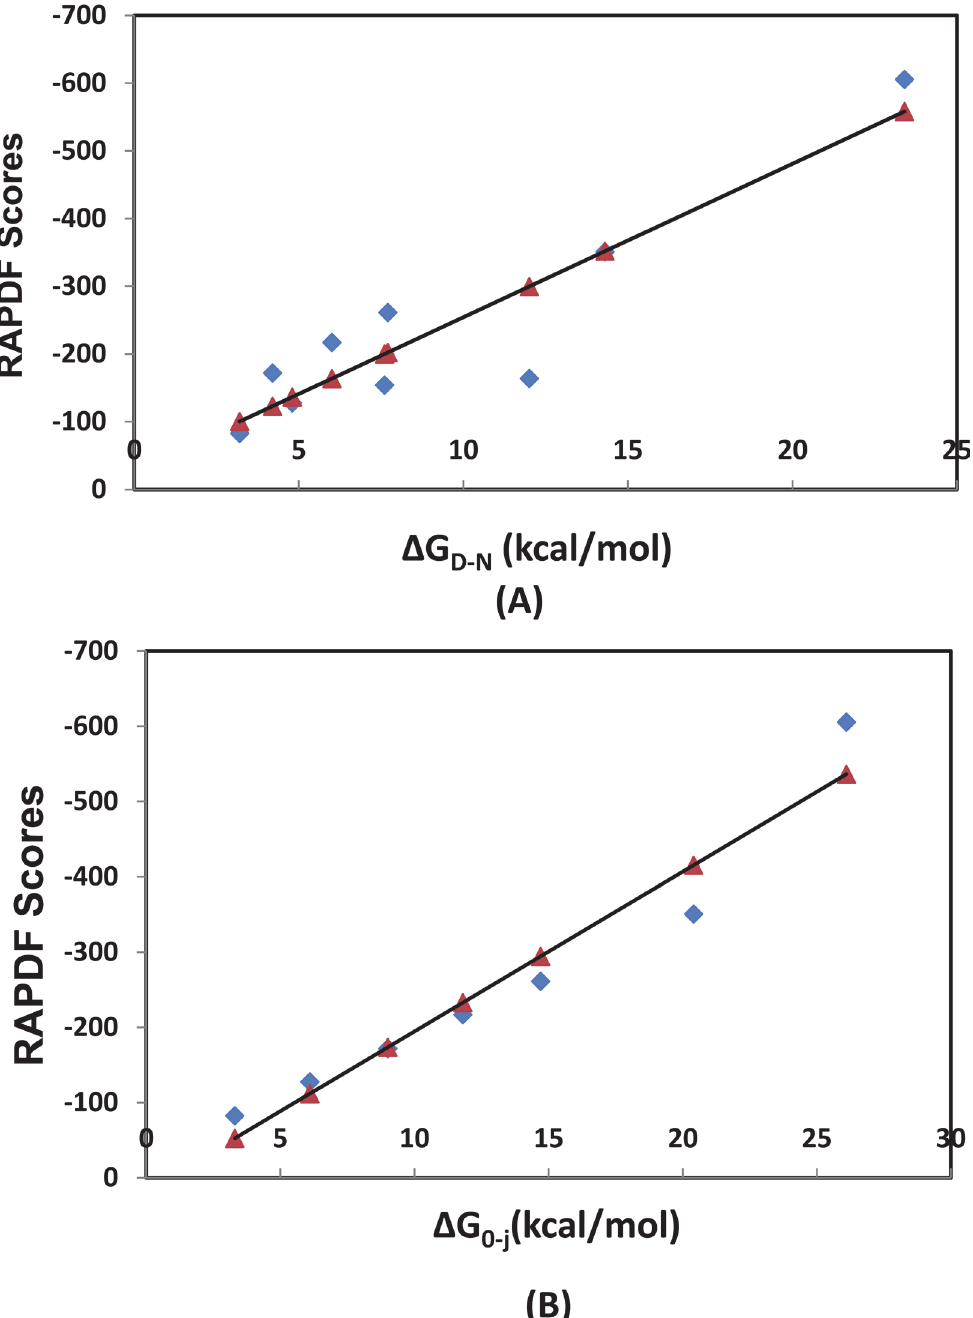
Fig 9. Correlation between the RAPDF scores of CTPRa n and the equilibrium unfolding free energies. (A) RAPDF scores versus Δ G D-N (kcal/mol), the thermal unfolding free energies (B) RAPDF scores versus Δ G 0-j (kcal/mol), the folding free energies calculated from fitting the Ising